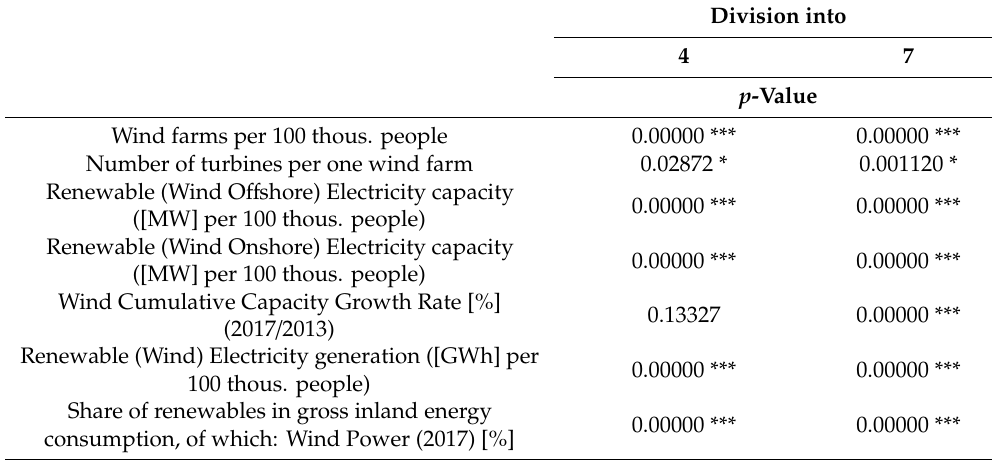
Division into 4 7 p -Value